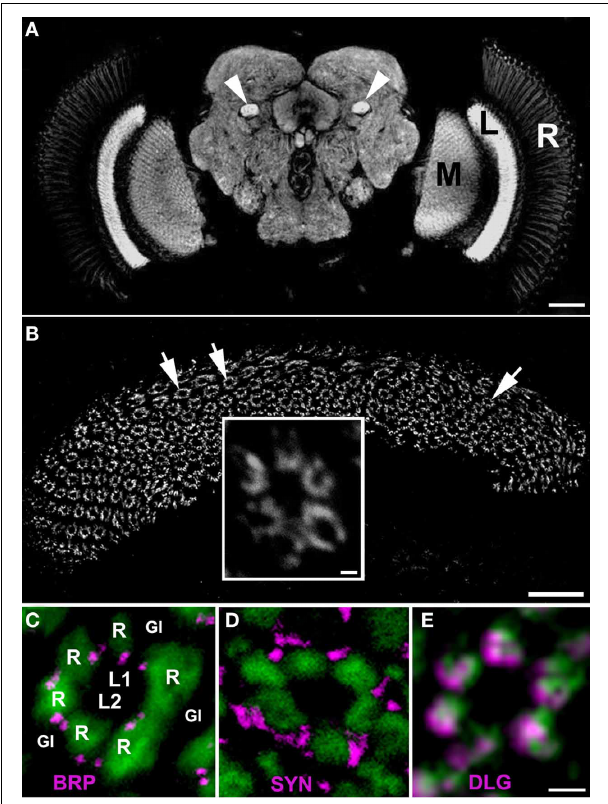
FIGURE 1 | (A) The synaptic neuropils of the lamina (L), medulla (M) and the central brain of Drosophila melanogaster visualized by anti–BRP immunostaining using Mab nc82. There is a strong fluorescent signal in the mushroom body pedunculi in the central brain as well (arrow heads). R, retina. Scale bar: 50 μ m. (B) The array of cartridges (arrows) in the cross sectioned neuropil of lamina as revealed by immunostaining using Mab 4F3 against DLG. Scale bar: 20 μ m. Insert: the magnification of a single cartridge. Scale bar: 1 μ m. (C–E) Cross sections of cartridges of GMR-Gal4 × UAS-S65T-GFP transgenic flies showing targeted expression of a green fluorescent protein (GFP) in photoreceptors (green) and immunolabeling (magenta) with Mab nc82 against BRP (C) , 3C11 against SYN (D) and 4F3 against DLG (E) . R—the terminals of six photoreceptors, L1, L2—interneurons receiving photic and visual information from photoreceptors, the so-called large monopolar cells (LMCs), Gl—the epithelial glial cells that surround lamina cartridges. Scale bar: 1 μ